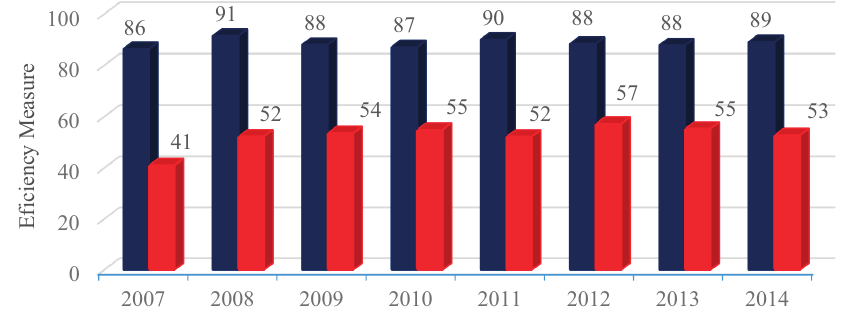
Figure 3. Comparison of the evolution of average ef fi